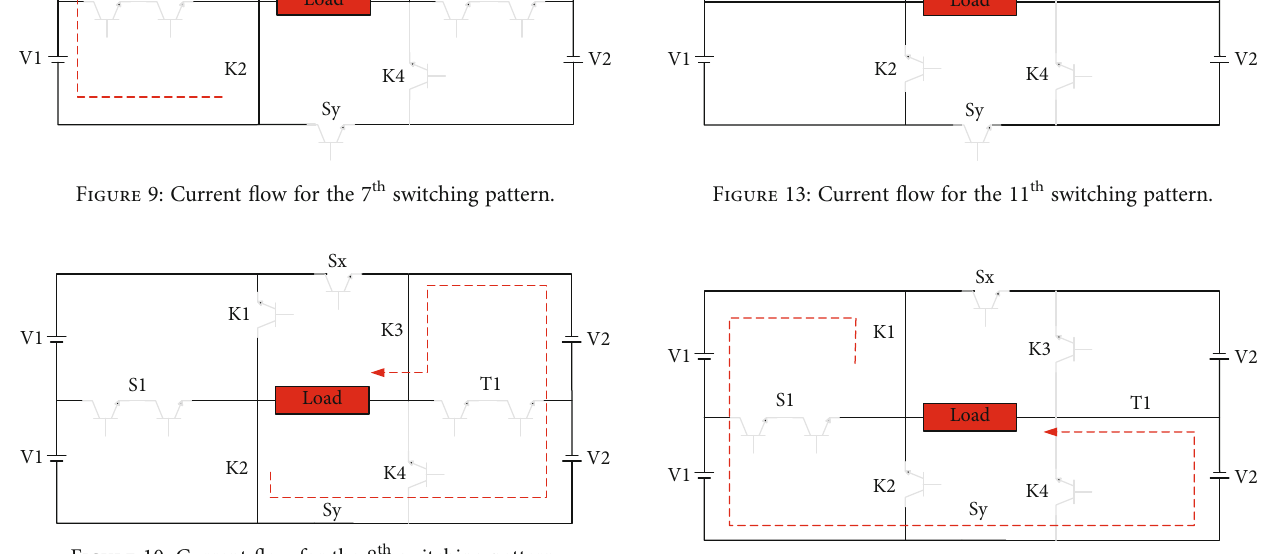
Figure 14: Current fl ow for the 12 th switching pattern.